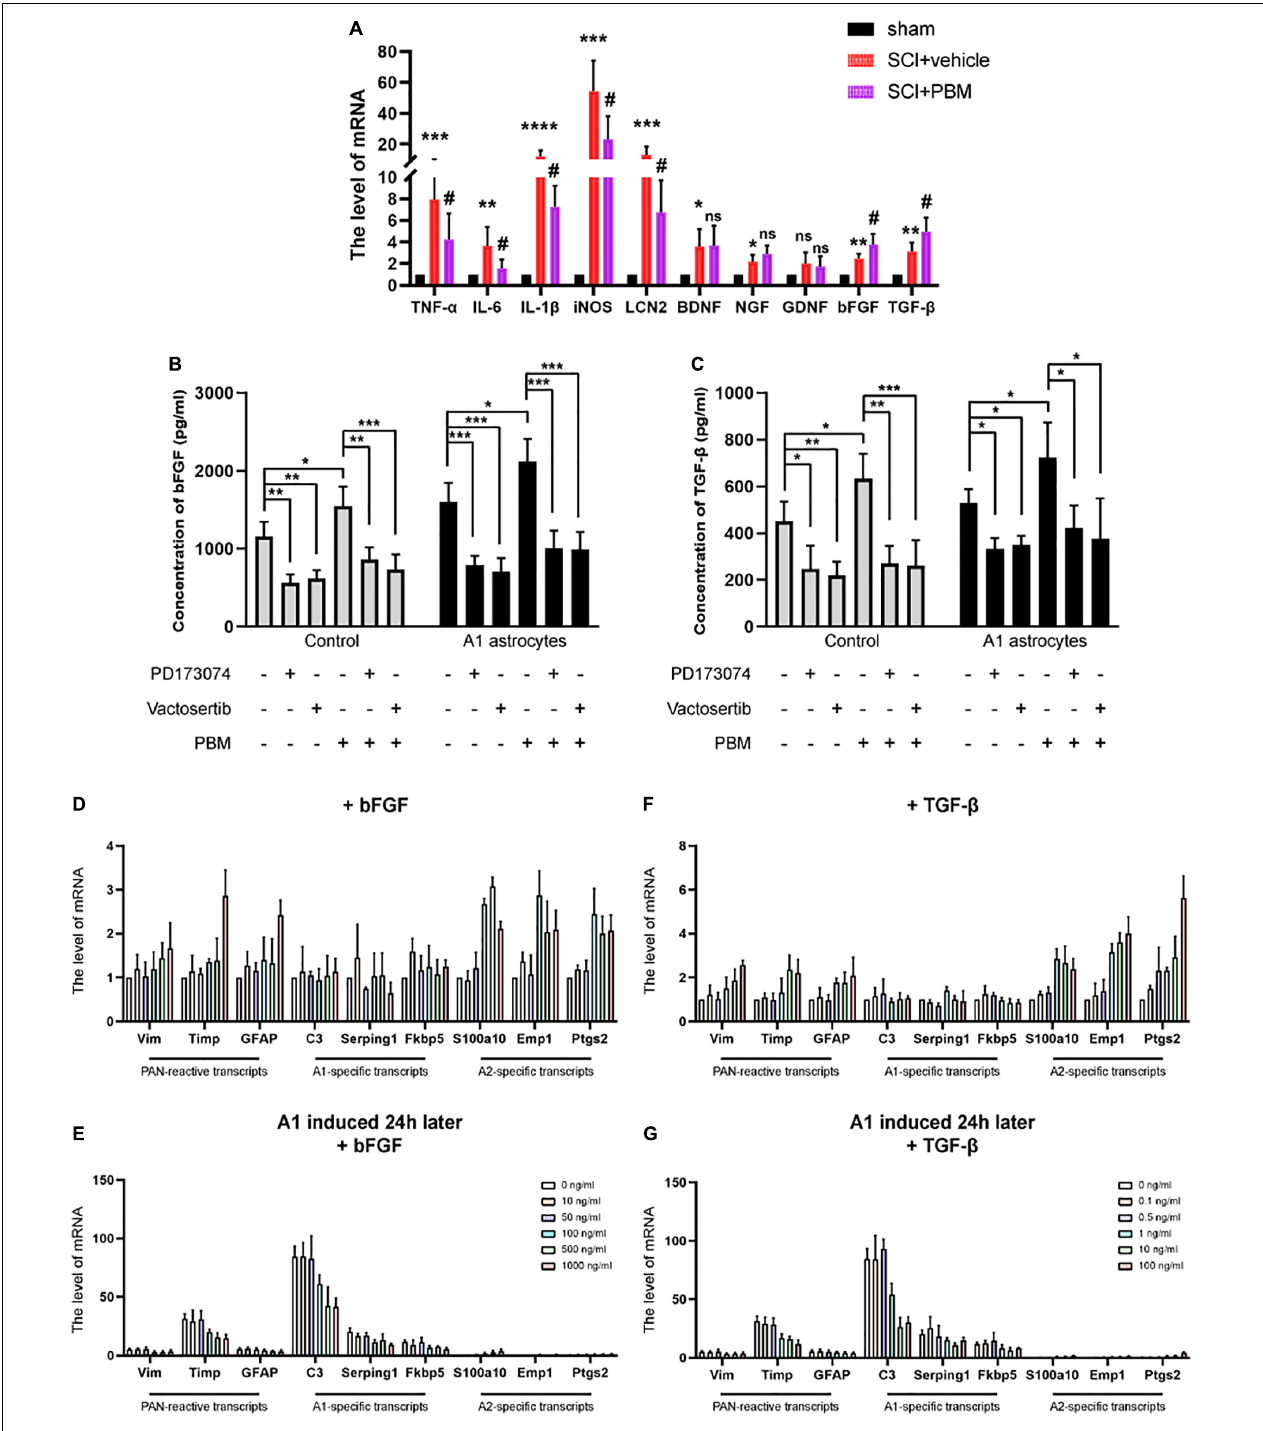
FIGURE 5 | Basic fibroblast growth factor and TGF- β expression was upregulated by PBM and inhibited by A1 astrocyte activation. (A) The mRNA levels of proinflammatory factors and neurotrophic factors in each group at 3 dpi. n = 5 individuals per group. * p < 0.05, ** p < 0.01, *** p < 0.001, **** p < 0.0001, the SCI + vehicle group vs. the sham control group; # p < 0.05, ns, not significant, the SCI + PBM group vs. the SCI + vehicle group. (B,C) The levels of bFGF and TGF- β in the indicated medium were measured by ELISA. The experiments were independently repeated four times. * p < 0.05, ** p < 0.01, *** p < 0.001. (D,F) The effect of different concentrations of bFGF and TGF- β on reactive astrocyte-related transcript levels in resting astrocytes. (E,G) The effects of different concentrations of bFGF and TGF- β on reactive astrocyte-related transcript levels in A1 astrocytes 24 h after induction. The data are shown as the fold change compared to the control group, as determined by RT-PCR. The experiments were independently repeated three